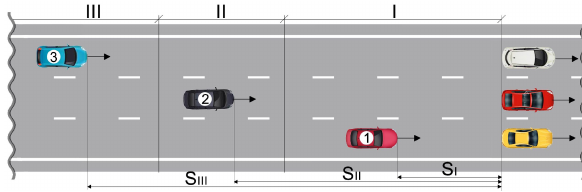
Figure 4: Qualitative distinction and location of vehicle location areas behind preceding, depending on the caution or carelessness which characterizes the